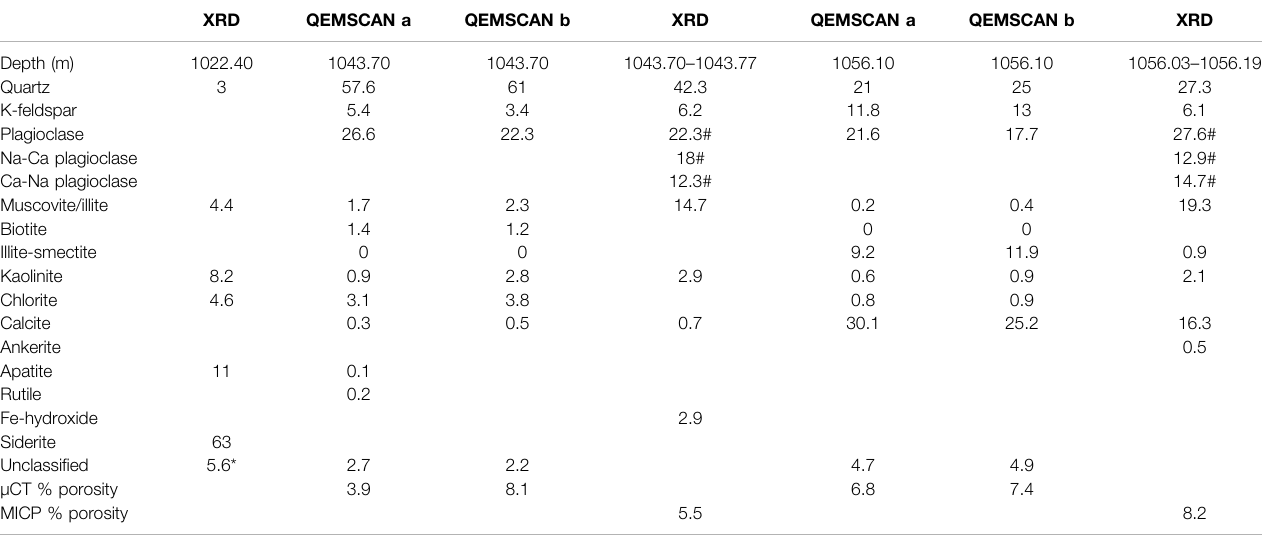
TABLE 2 | Mineral content (%) of the Evergreen Formation samples from XRD and QEMSCAN, where “ a ” and “ b ” are two adjacent sub-sample areas. Micro CT and MICP porosity (%) is also shown where measured. XRD was performed on a powdered section of core as reported previously (Golding et al., 2019). QEMSCAN minerals and porosities were also reported previously (Pearce et al., 2019b).